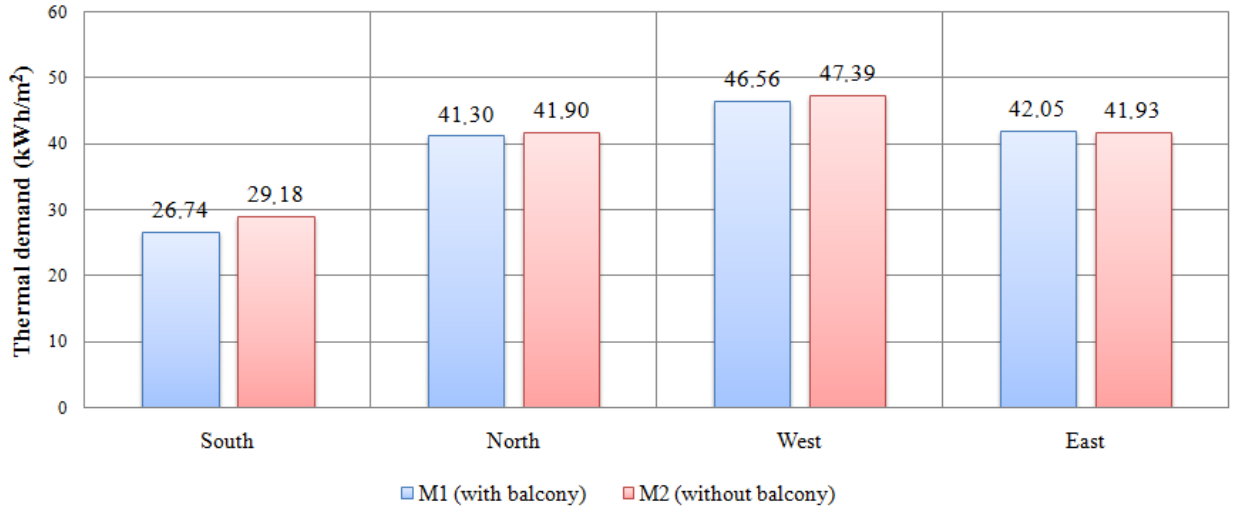
Figure 7. Annual thermal demand by geographic